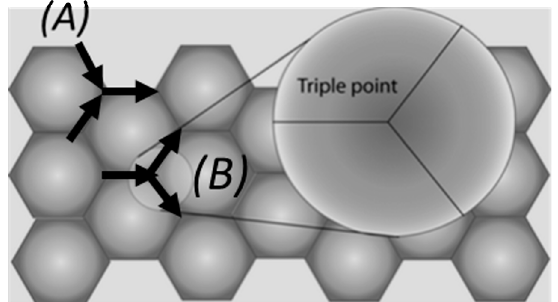
Figure 2. A triple point region is the junction where crystallographic directions change from one grain to the next. These points are the usual spots where regions of depletion or accumulations occur, and it depends on the structure of the triple point. ( A ) Two grain boundaries leading to a single grain boundary will lead to mass accumulation and therefore to hillock formation. ( B ) If one grain boundary leads to two grain boundaries, there will be an area of depletion of mass causing voids.